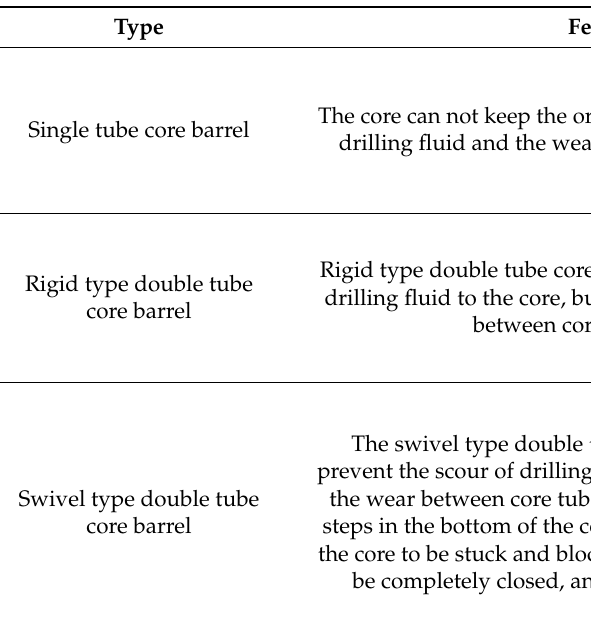
Table 1. Three common coring barrels for loose sandstone-type uranium